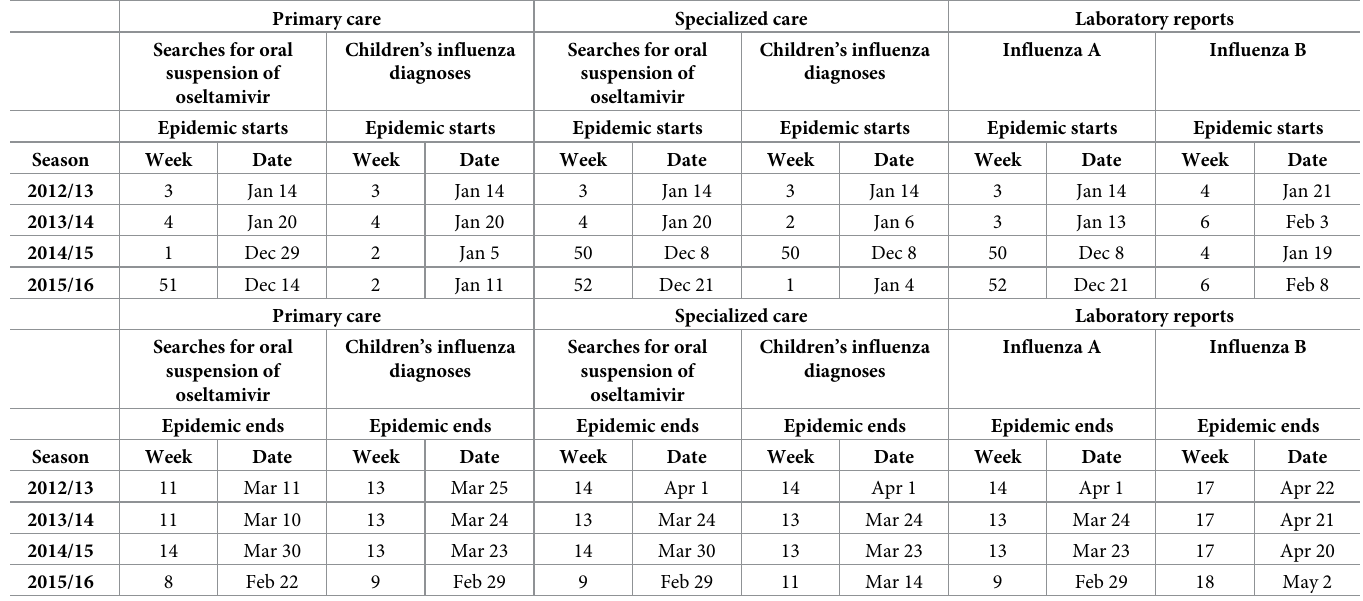
Table 2. MEM-calculated starts and ends of the epidemic seasons by searches for oseltamivir oral suspension and children’s influenza diagnoses in primary and spe- cialized care, and laboratory reports of children’s influenza A and B in Finland